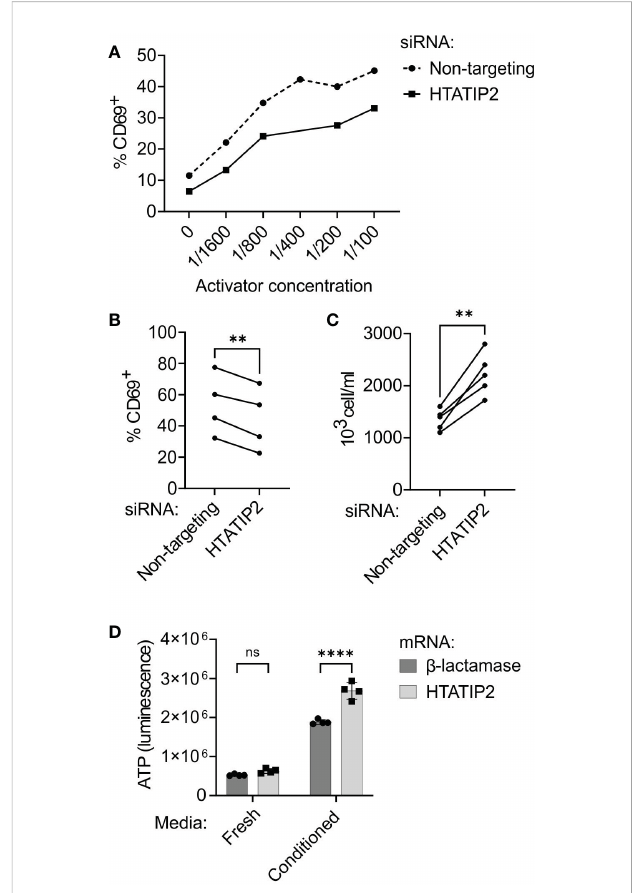
FIGURE 6 Knock-down or overexpression of HTATIP2 modi fi es T cell receptor signaling, proliferation, and viability. (A) siRNA-transfected CD4 + cells were activated with different concentrations of antibodies to T cell receptor CD3/CD28 chains and stained for CD69 expression (representative experiment). The percentage of CD69-positive cells at each concentration is shown for HTATIP2 knock-down and non- targeting control. (B) Summary of results from four trials with unique donors of the experiment in panel (A) . Activator concentration is 1:100. (C) CD4 + cells from fi ve donors were transfected with siRNA and seeded at 600,000 cells/ml. The cells were counted 72 h post- transfection. (D) CD4 + cells from a human donor were transfected with in-vitro transcribed mRNA for the control E coli b -lactamase gene or for HTATIP2. After electroporation, the cells were seeded in either fresh complete RPMI medium, or 50% spent medium from activated T cells. The cells underwent bioluminescent ATP assay at 72 h post-transfection. ** P < 0.01, **** P < 0.0001. ns, non-signi fi